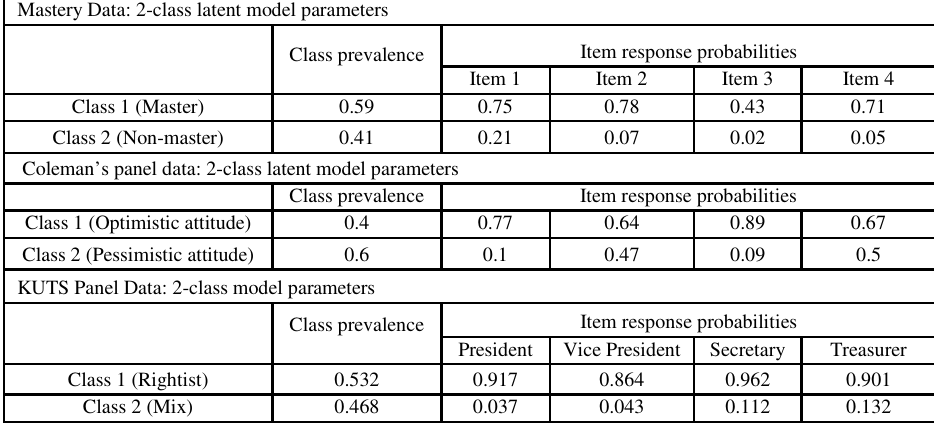
TABLE 1: INITIALLY ESTIMATED PARAMETERS (IEP) FOR A 2-CLASS LATENT MODEL OF MASTERY, COLEMAN’S PANEL AND KUTS DATA. Mastery Data: 2-class latent model